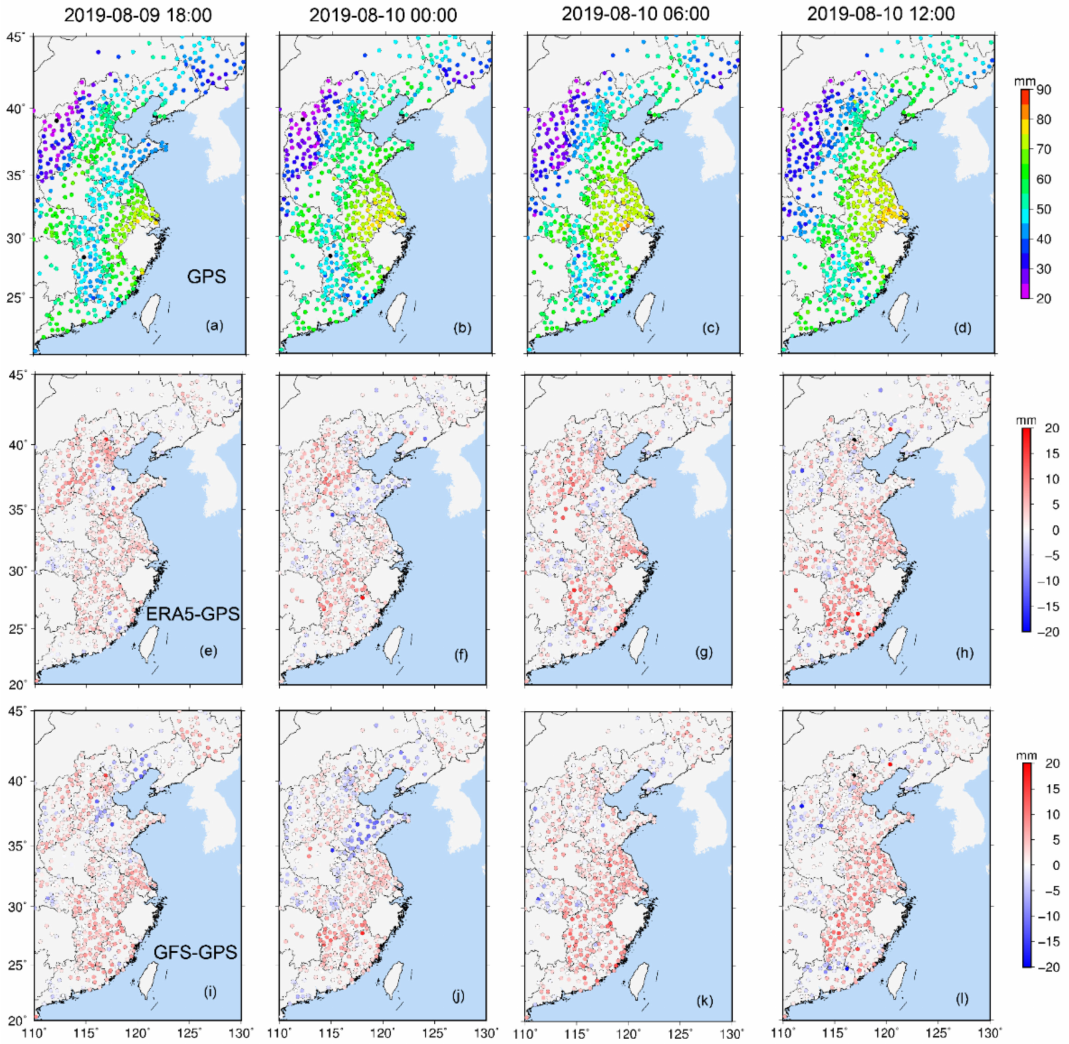
Figure 3. ( a – d ) PWV spatial distribution at UTC time 9 August 18:00, 10 August 00:00, 10 August 06:00 and 10 August 12:00, respectively; ( e – h ) PWV difference (ERA5 minus GPS) at the four epochs; ( i – l ) PWV difference (GFS minus GPS) at the four